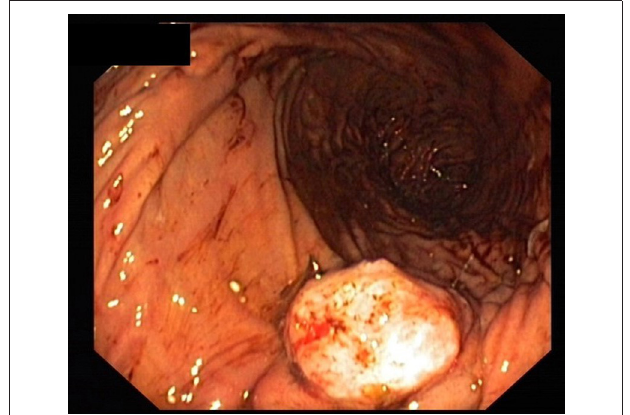
FIGURE 3 | Pancreatic stump after drainage removal.